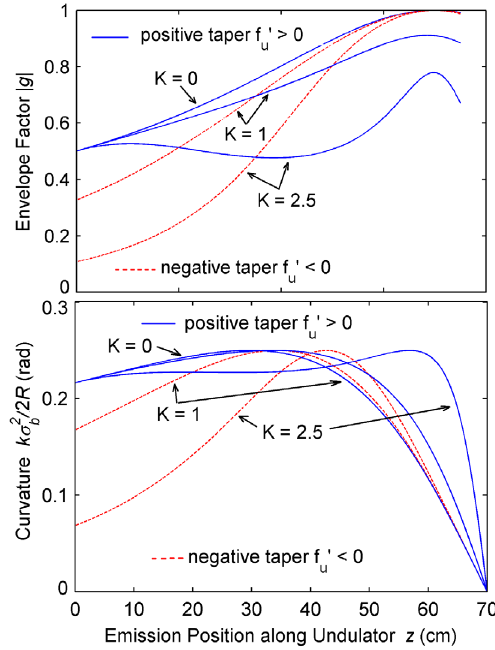
= 2 R ð z Þ along the b ¼ z=L ¼ ð 1 − z=L Þ and f u u u u